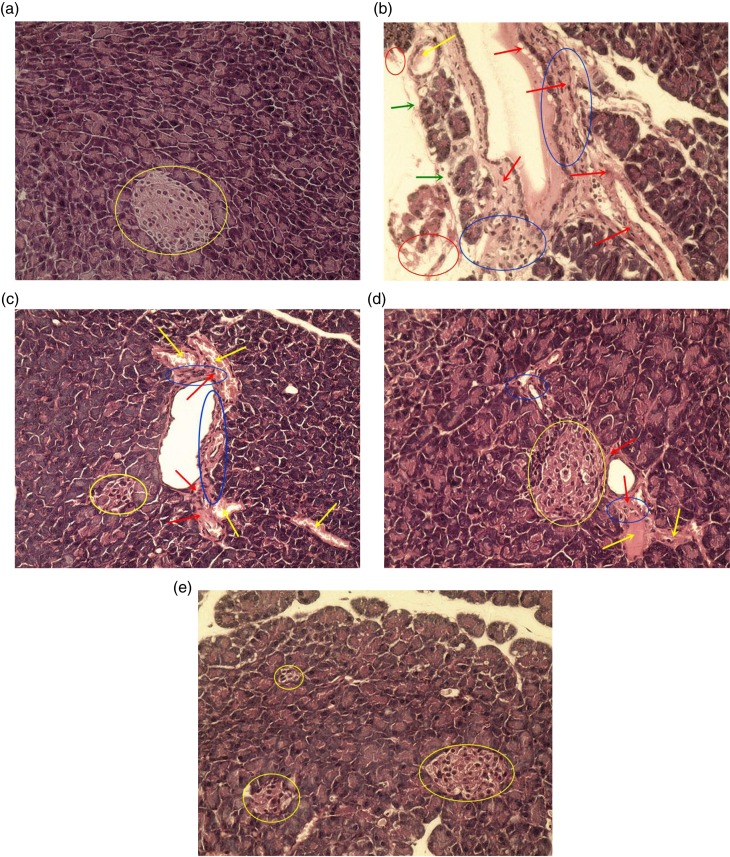
The effect of MBBP on pathologic tissue in the pancreas (×400). The graphs were representative of the 10 mice in each group. (a) normal mice fed with a standard diet; (b) model mice fed with a standard diet; (c–e): treated mice fed with 2.5, 5.0, and 10.0% MBBP diets, respectively; blue circle means minute inflammatory cell infiltration; yellow circle indicates pancreas islet; red arrow means slight interstitial proliferation and angionecrosis; blue arrow means degeneration of superficial adipocytes; yellow arrows mean tiny congestion of vascellum and prominent vasodilation.